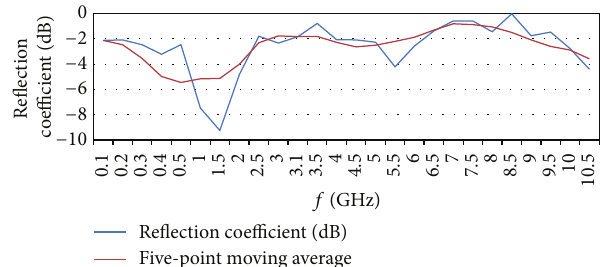
Figure 6: Reflection coefficient from heart at the end of diastole. A five-point moving average is superimposed for a clearer understand-